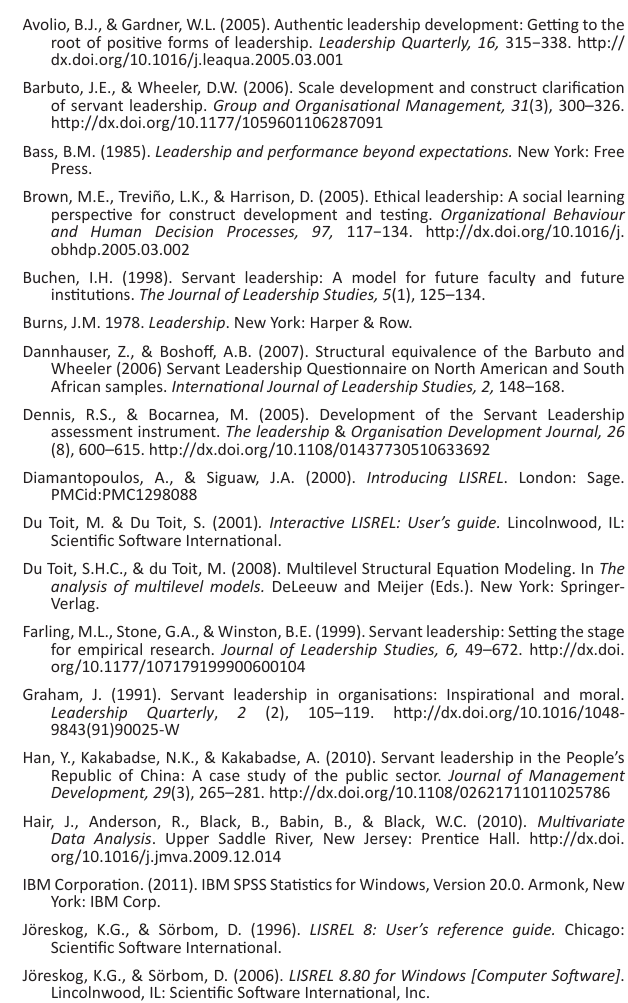
RMSEA, root mean square error of approximation; df , degrees of